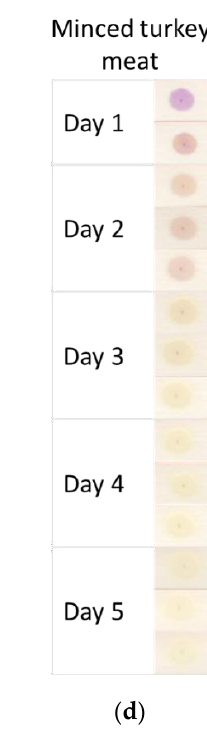
Figure 8. Color evolution of CR-CMC@/Cell sensors over slices of chicken breast ( a ), minced chicken meat ( b ), slices of turkey breast ( c ) and minced turkey meat ( d ) during chilled storage at 4 °C for 5 days.